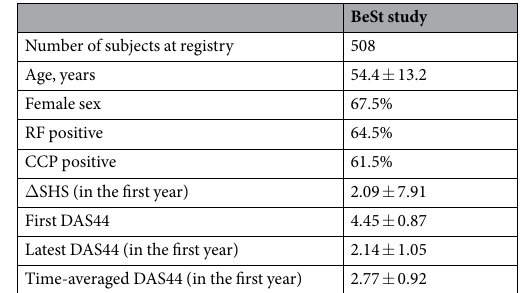
Table 2. Characteristics of subjects in the BeSt study.